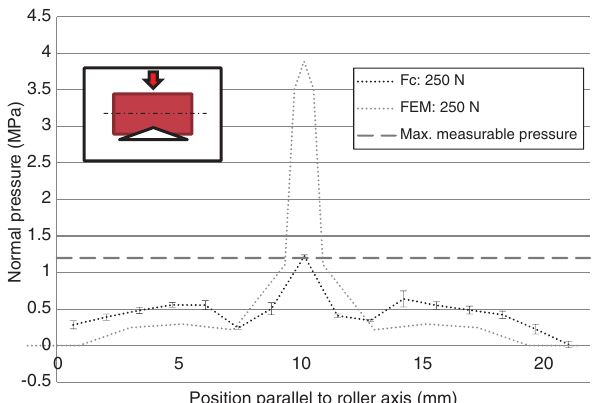
Figure 22 Normal pressure of the compaction roller on the convex tool in lateral direction parallel to roller axis.